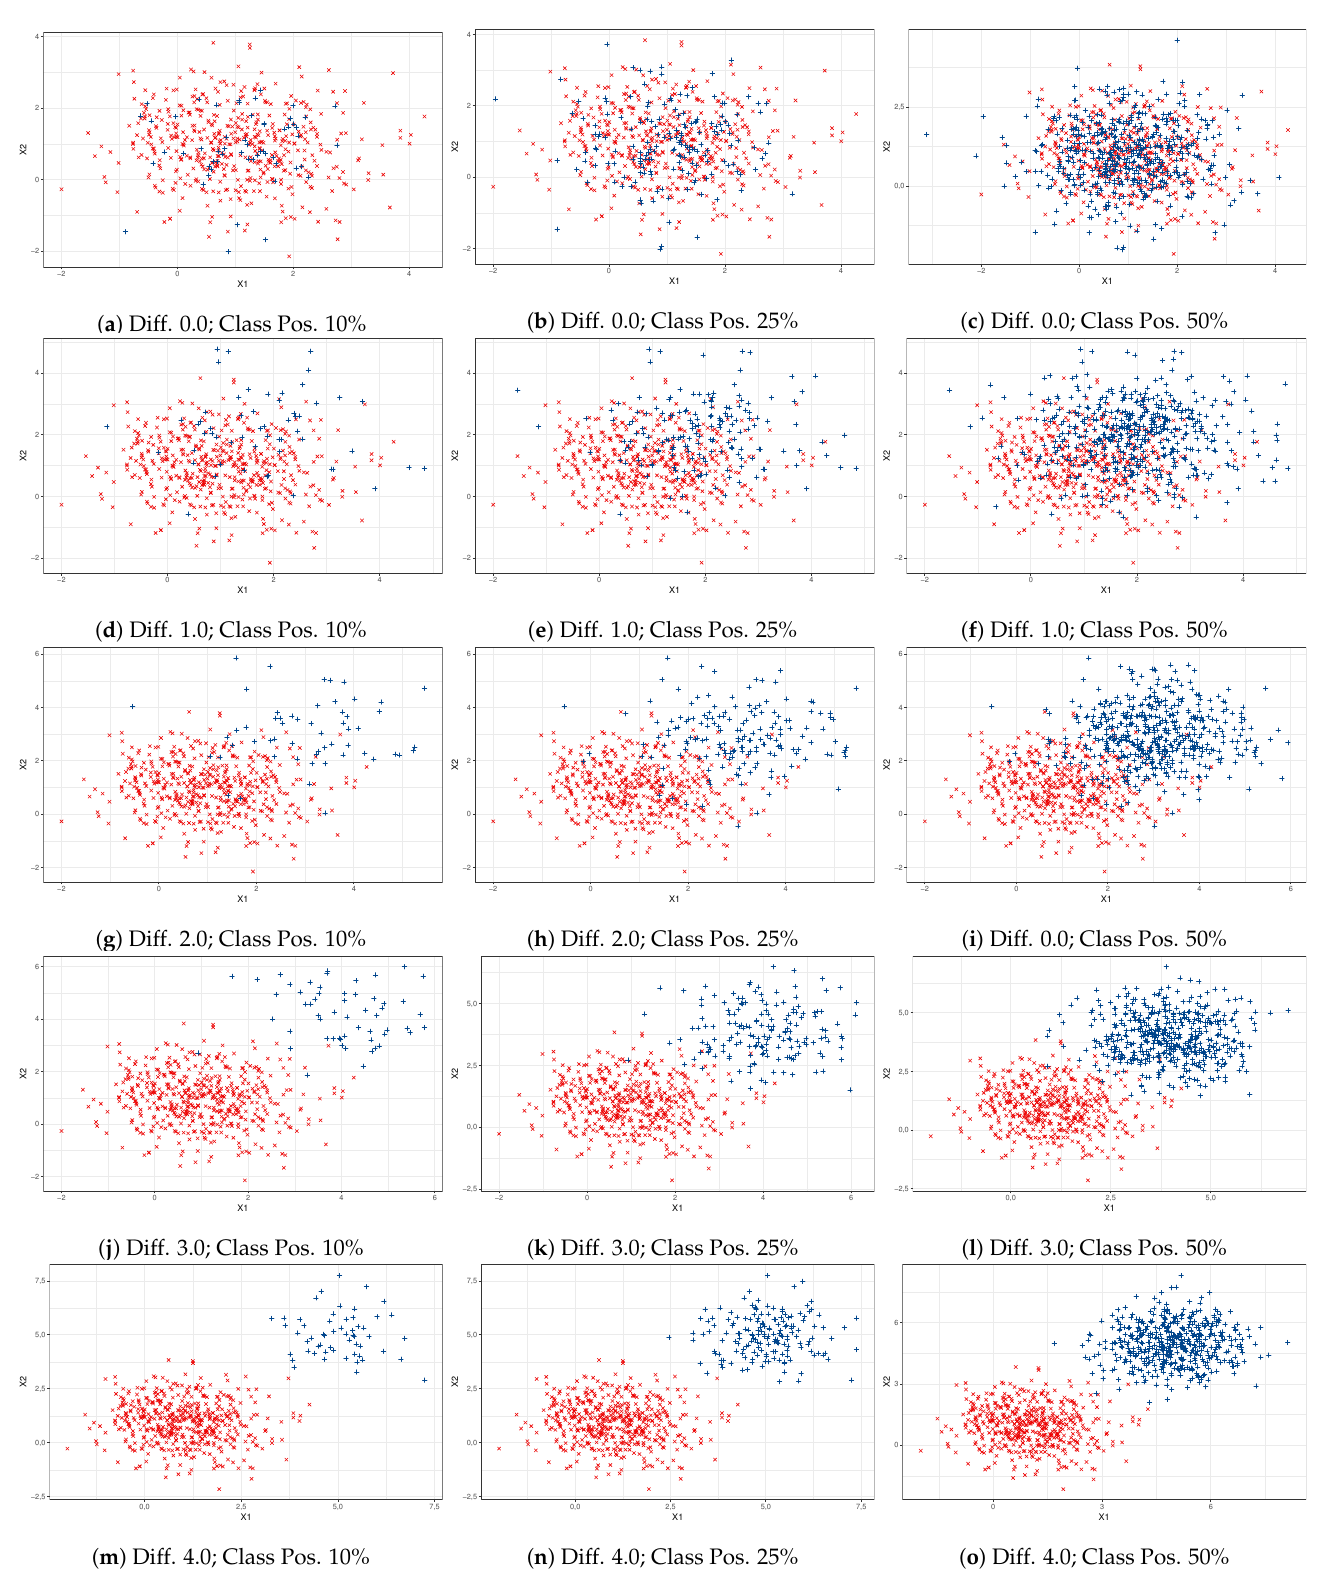
Figure 3. Distribution of the artificial datasets in different configurations of imbalanced rate and overlapping. The red x represents the negative class, while the blue + represents the positive